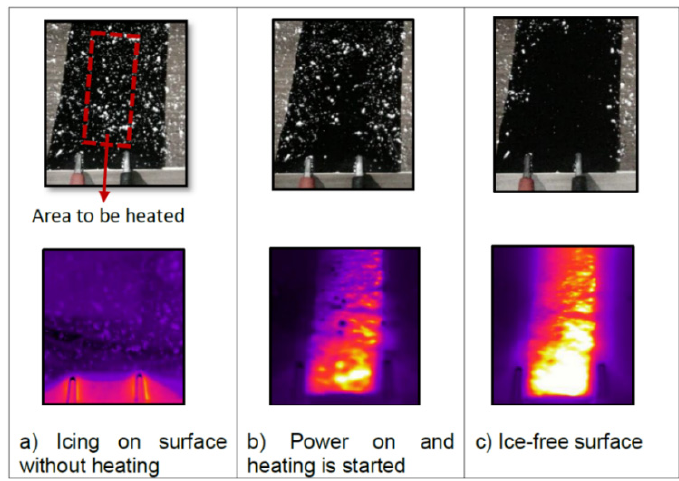
Figure 12. Demonstration of anti-icing effect of the sheet coated by CNTs produced by the roll-to-roll method (IR and color images) under atmospheric icing conditions. Reprinted with permission from [79].